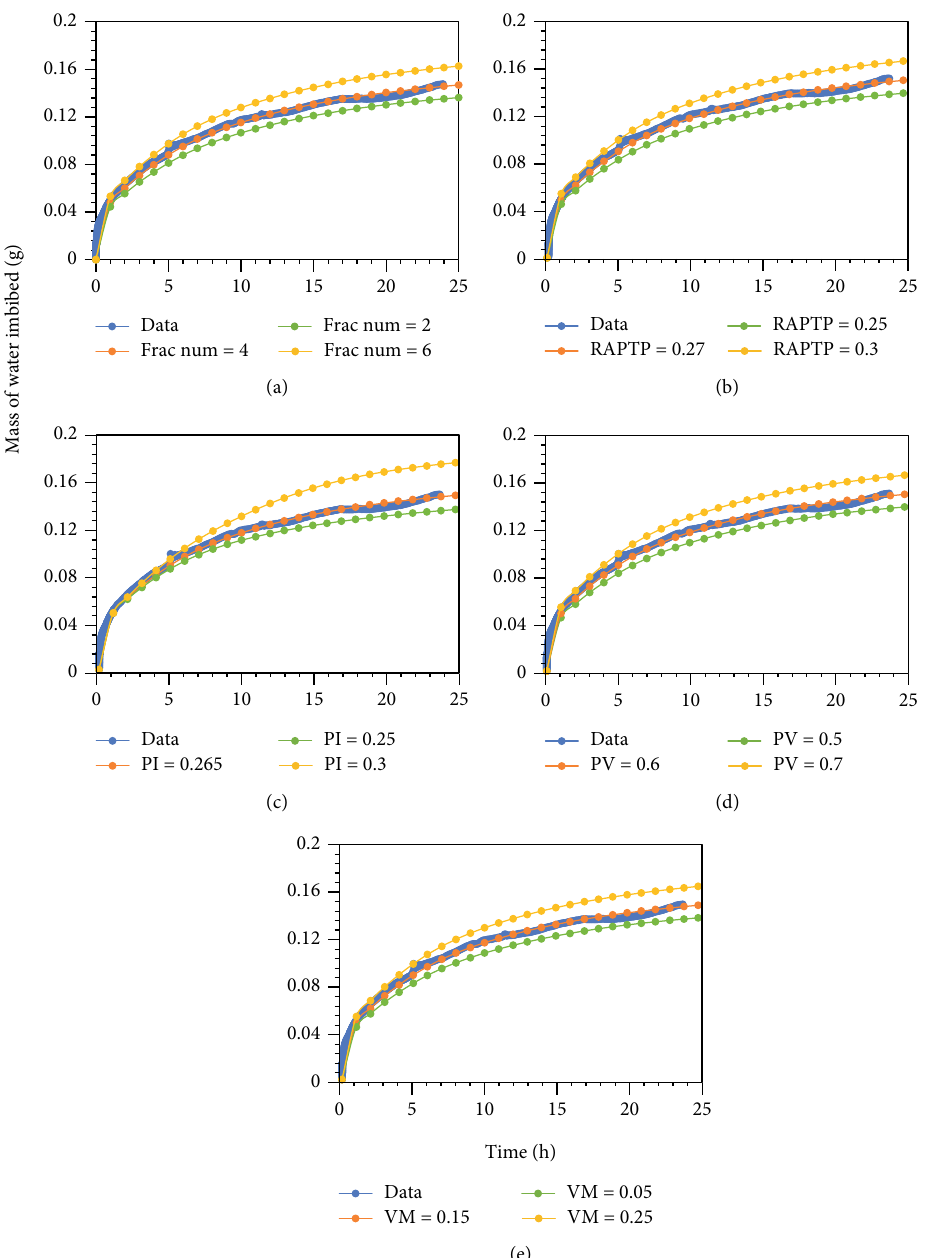
Figure 13: Comparison of laboratory data with simulation results for the T direction sample for the imbibed water mass with respect to (a) numbers of fully saturated fractures (FN) in the fi rst simulation step, (b) RAPTP, (c) PI in matrix cells, (d) PV in matrix cells, and (e) MV in matrix